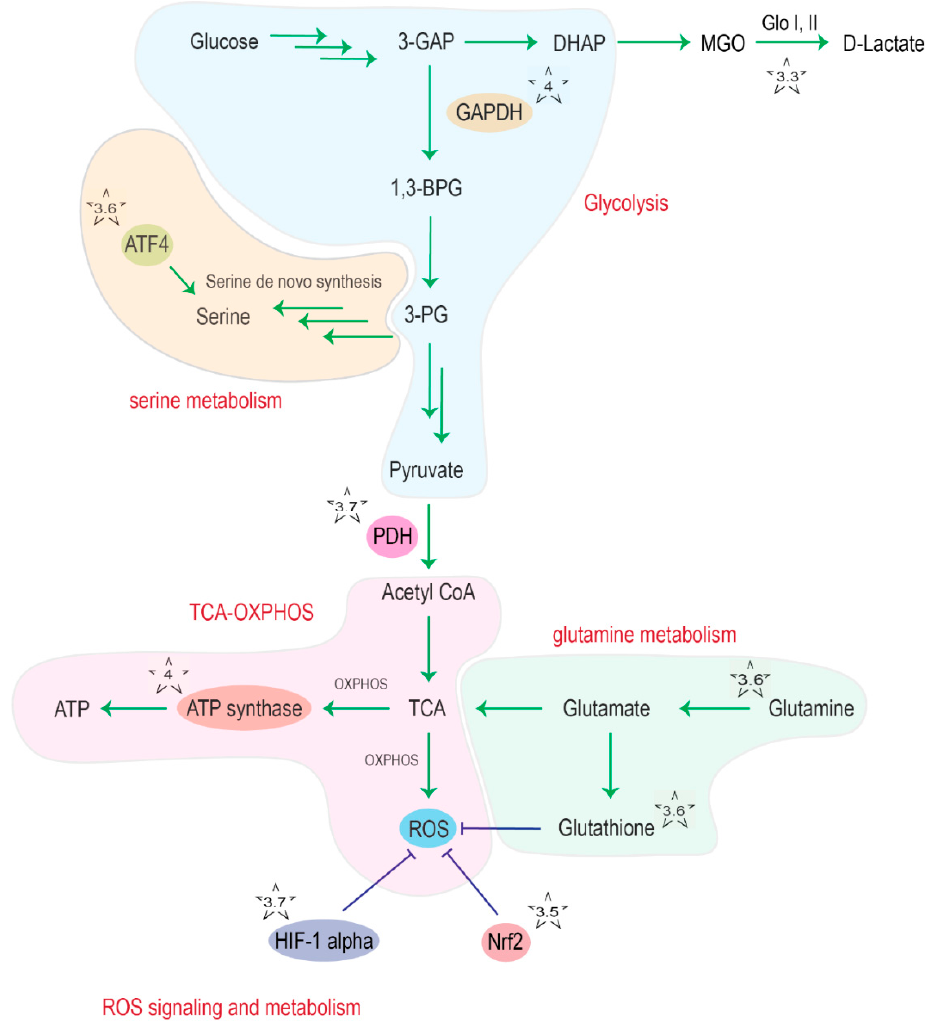
Figure 1. Overview of DJ-1 interaction points (indicated with a star) with cellular metabolism. The chapter discussing the indicated interaction points is given as number in the respective star. Abbreviations: 3-GAP: glyceraldehyde 3-phosphate; DHAP: dihydroxyacetone phosphate; MGO: methyglyoxal; Glo: glyoxalase, GAPDH; glyceraldehyde 3-phosphate dehydrogenase; 1,3-BPG: 1,3-bisphosphoglycerate; 3-PG: 3-phosphoglycerate; ATF4: activating transcription factor 4; PDH: pyruvate dehydrogenase; TCA: tricarboxylic acid cycle; OXPHOS: oxidative phosphorylation; ROS: reactive oxygen species; Nrf2: nuclear factor erythroid 2-related factor